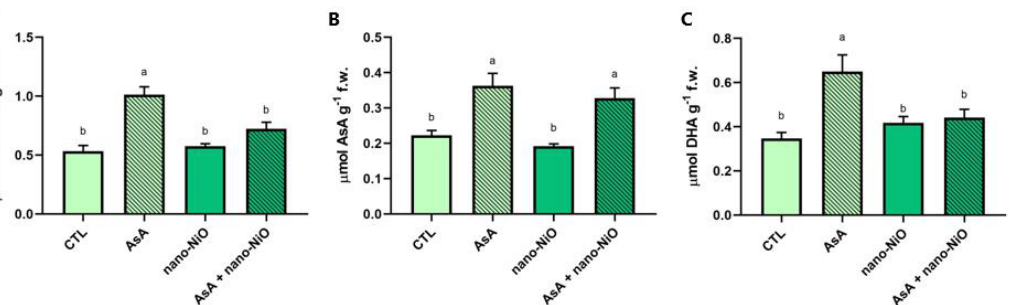
Figure 6. Effects of nickel oxide nanomaterials (nano-NiO; 30 mg L − 1 ) and/or ascorbate (AsA; 150 mg L − 1 ) on the content of total ascorbate (total AsA; A ), reduced ascorbate (AsA; B ), and oxidized ascorbate (DHA; C ) in the shoots of in vitro grown tomato plantlets. Data presented are mean ± SEM (n ≥ 3) (f.w.: fresh weight). Different letters above bars indicate significant statistical differences between treatments at p ≤ 0.05.